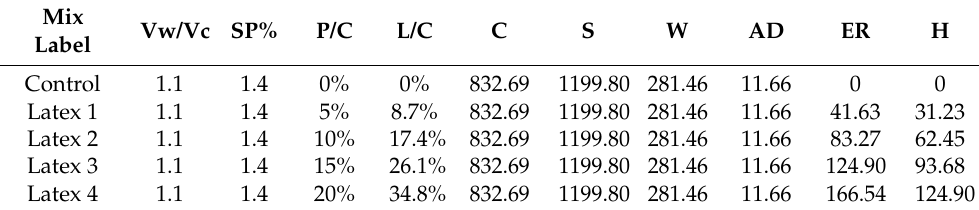
Table 2. Mix proportions of epoxy latexes modified mortar